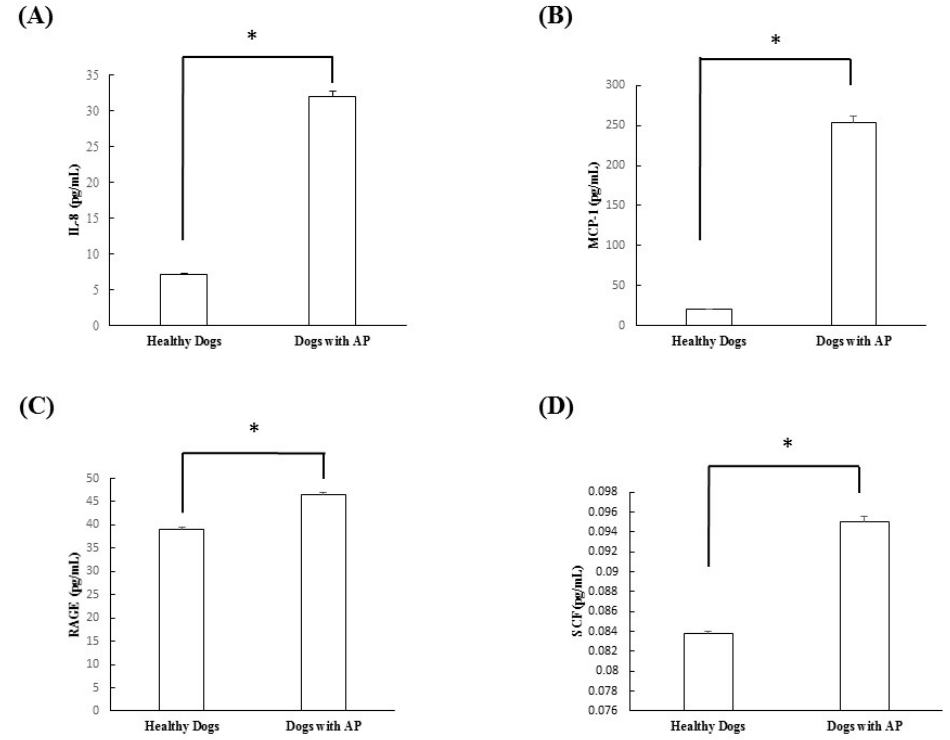
Figure 2. Comparison of ( A ) IL-8, ( B ) MCP-1, ( C ) RAGE, and ( D ) SCF in dogs with suspected acute pancreatitis (n = 8) and healthy dogs (n = 8) by canine serum enzyme-linked immunosorbent assay. * p < 0.05. AP: suspected acute pancreatitis